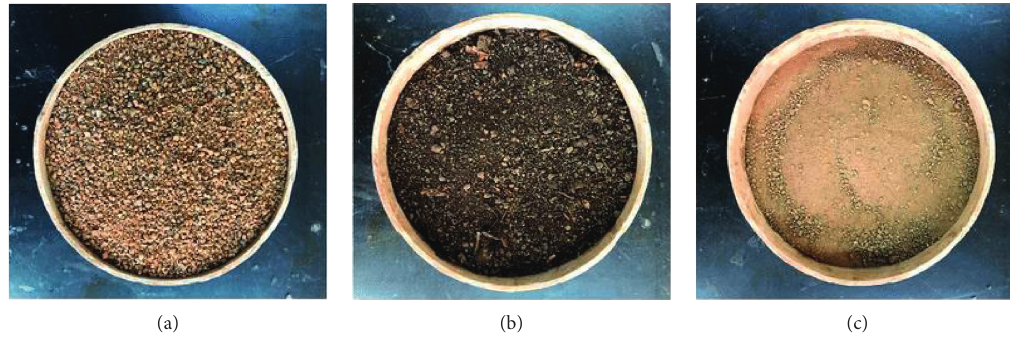
Figure 1: A soil sample from 3 different locations.